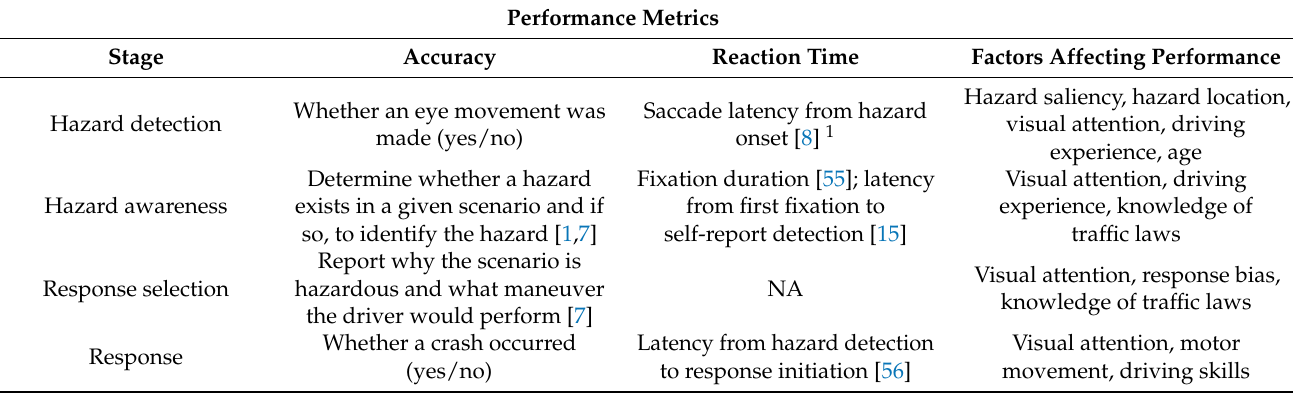
Table A2. Performance metrics to evaluate hazard perception–response framework and factors affecting